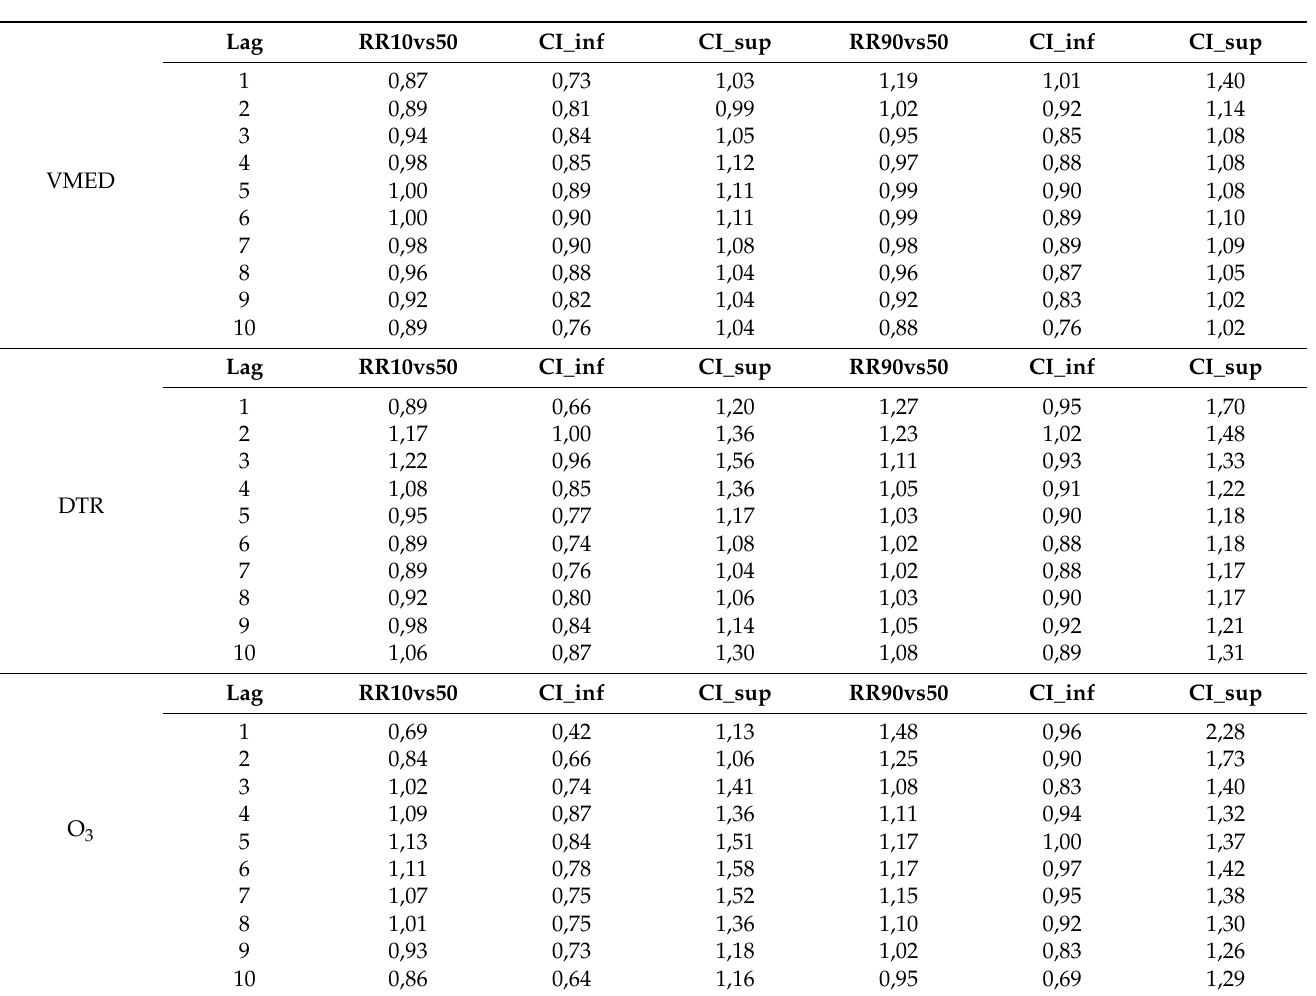
Table 3. Relative risk of hospital admission in the lowest (“RR5vs10”) and highest tail of the variable distribution (“RR95vs90”). PMED: mean atmospheric pressure; PMIN: minimum atmospheric pres- sure, TMAX maximum temperature; TMED: mean temperature; D2D: temperature difference